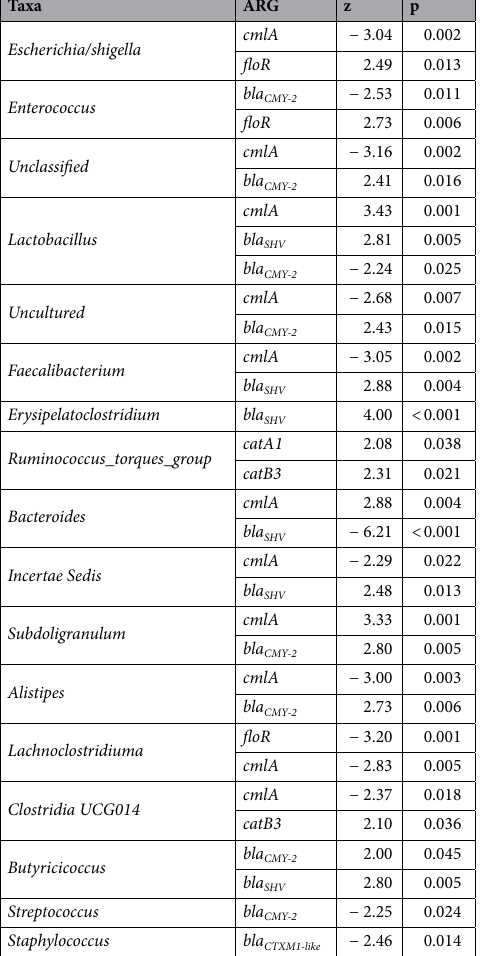
Table 1. Significant associations between microbial taxa and antimicrobial resistance genes. Z and p values are reported.